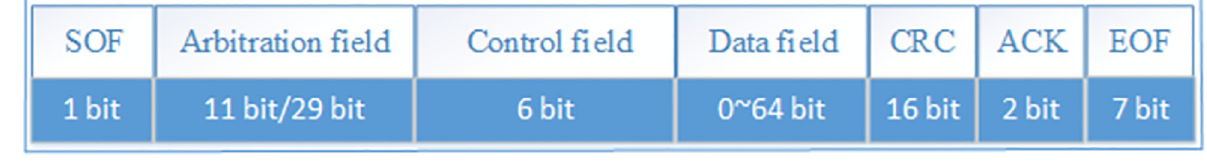
Fig 1. Structure of the CAN